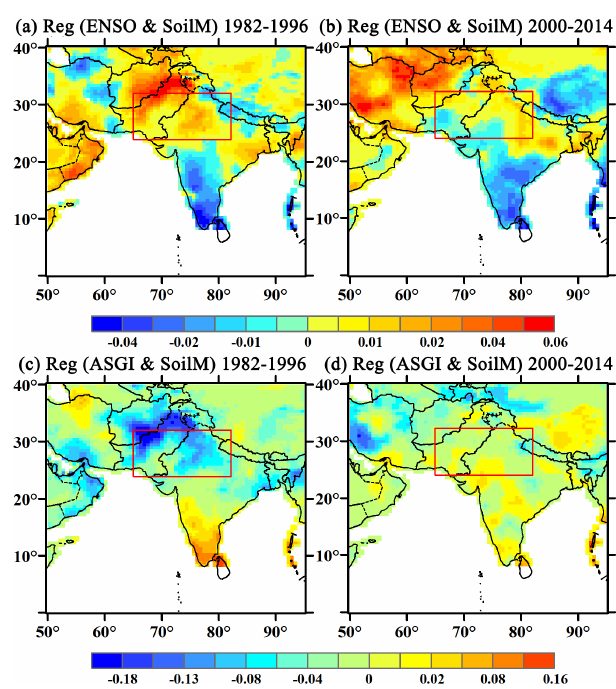
Figure 8. (a–b) Regression of ENSO with ASGI-related signals re- moved onto SoilM in the dust season (June–July). (c–d) Regression of ASGI with ENSO-related signals removed onto SoilM in the dust season